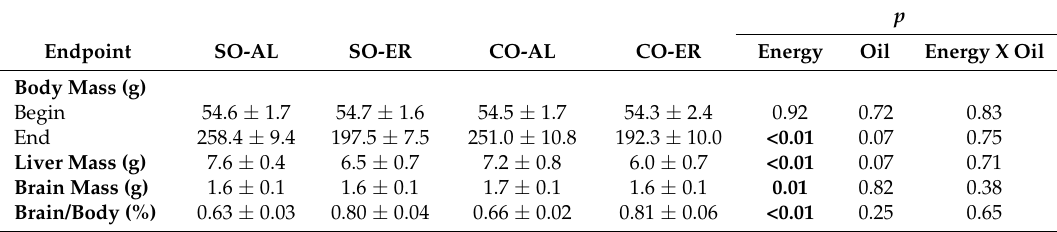
Table 1. Body composition in growing male rats.